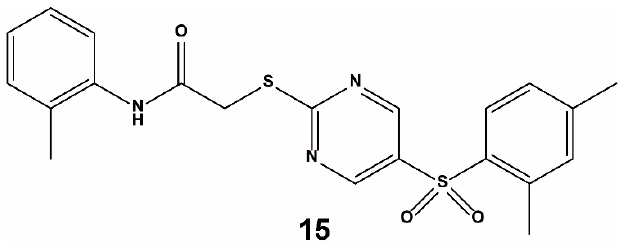
Figure 9. Structure of compound 15.